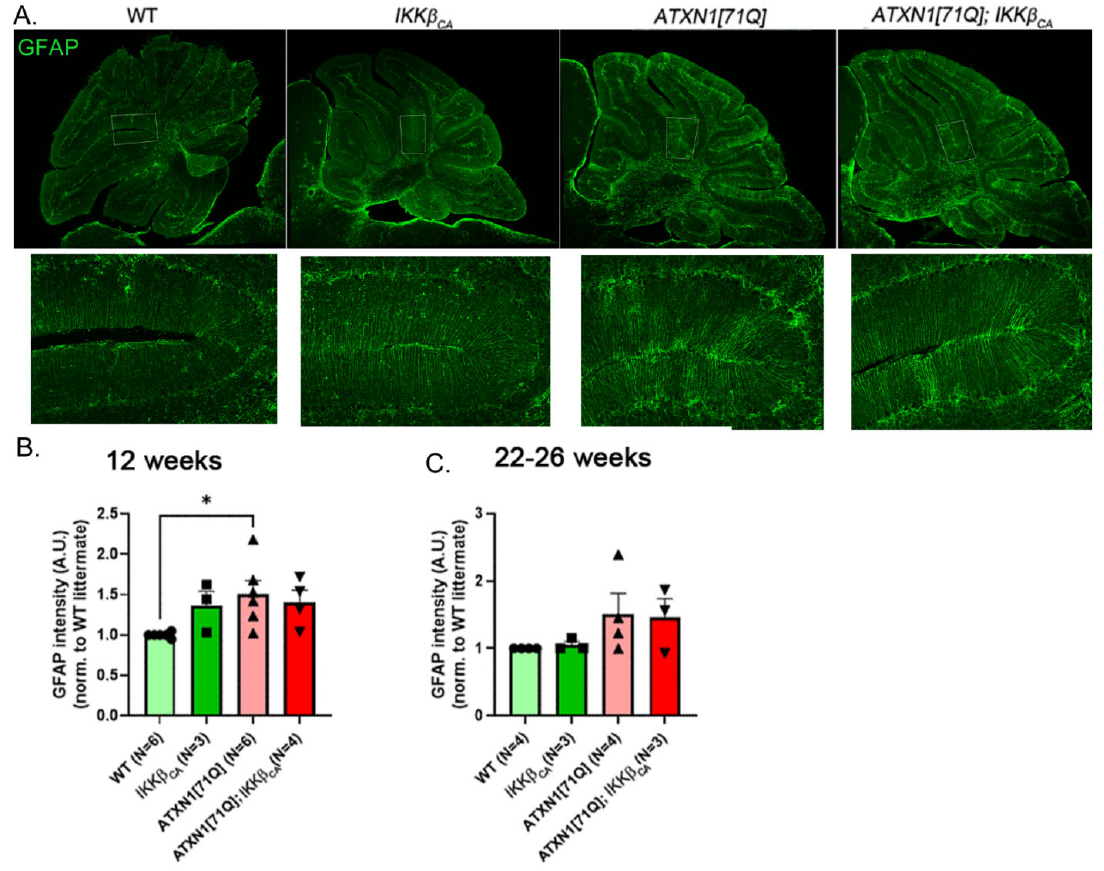
Figure 3. Bergmann glia GFAP intensity is increased in SCA1 mice but not significantly altered with IKK β CA expression. Representative GFAP immunofluorescence staining of the whole cerebellum of 12 ‐ week ‐ old mice. Boxed regions of the molecular layer are shown below ( A ). Image J was used to quantify the intensity of GFAP staining at 12 weeks ( B ) and 22–26 weeks ( C ). Data are presented as mean ± SEM with average values for each mouse represented by a dot * p < 0.05 using one ‐ way ANOVA with Bonferroni’s multiple comparison test. Error bars = S.E.M.